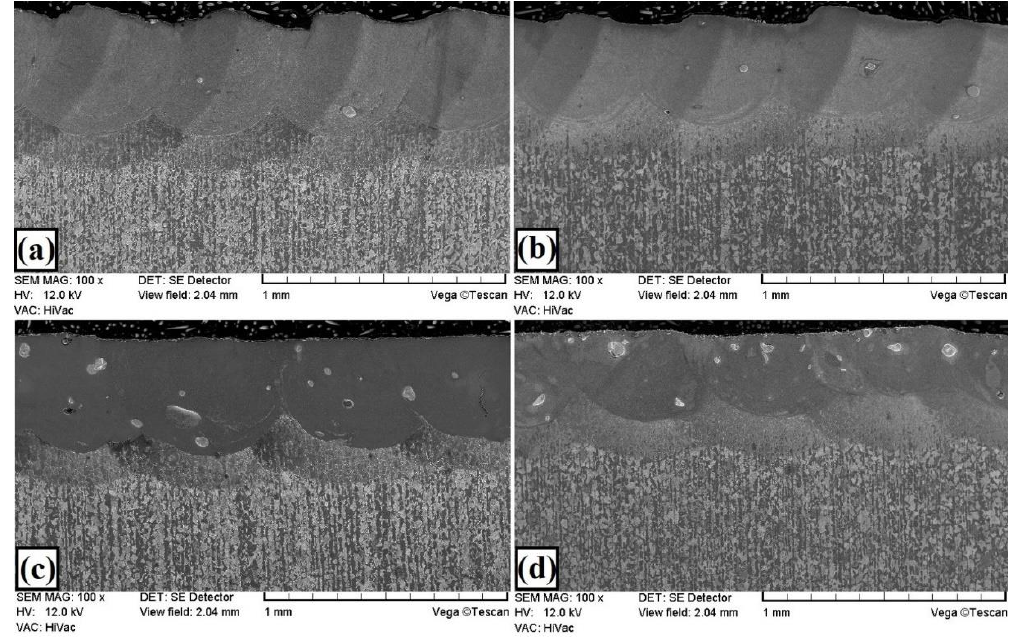
Figure 5 . Microstructure of coatings produced using laser processing of precoat applied on steel / 25% WC; ( b ) W–Cr / 50% WC; ( c ) W–Cr / 75% WC; ( d ) 100% substrate: ( a ) W–Cr/25% WC; ( b ) W–Cr/50% WC; ( c ) W–Cr/75% WC; ( d ) 100% WC . substrate: ( a ) W–Cr